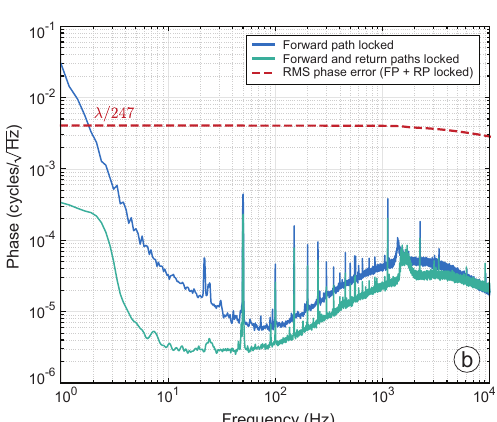
Figure 12. ( a ) Time series measurements of φ OOL when the OPA is forward path locked (blue), and fully locked (green) without DEHI. The inset shows the zoomed-in behaviour of φ OOL when fully locked. ( b ) RPSD of the measurements shown in ( a ); the noise-shelf at frequencies below 10 Hz is typical of cyclic phase noise introduced by parasitic interference somewhere in the optical system. The RMS phase error was calculated to be Φ RMS = λ /247 at 1 Hz, limited by noise at frequencies beyond 1 kHz.